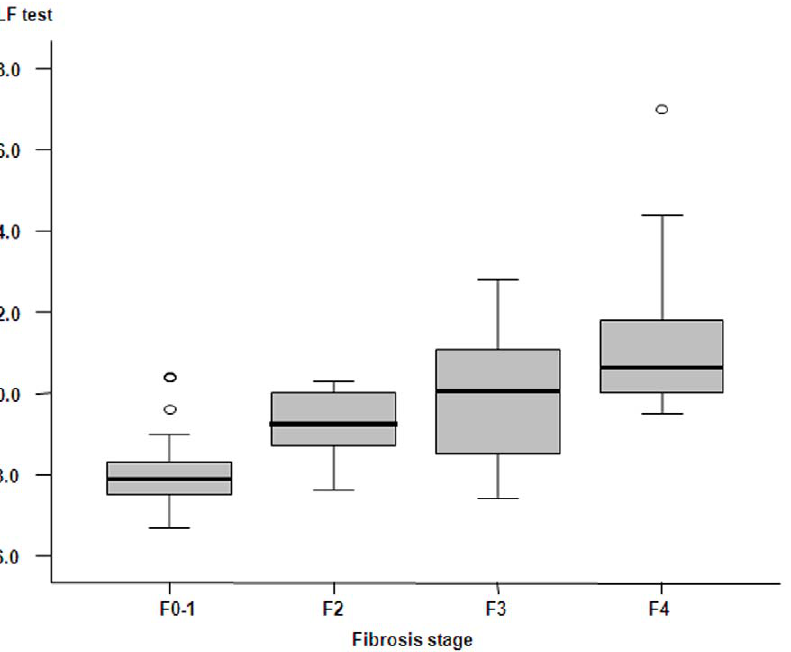
Figure 2. Box plots of ELF test according to fibrosis stage. Boxes and horizontal lines within boxes represent interquartile ranges (IQRs) and median values, respectively. The upper and lower whiskers indicate 75 th percentile plus 1.5 IQR and 25 th percentile minus 1.5 IQR, respectively. o, mild